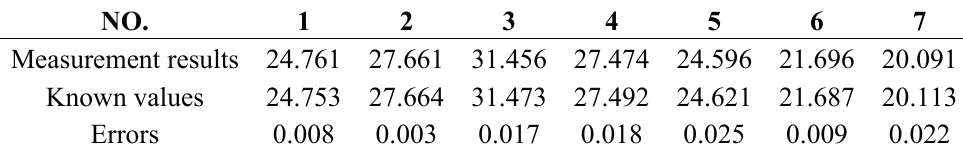
Table 4. Measurement results for shaft 2 (mm).